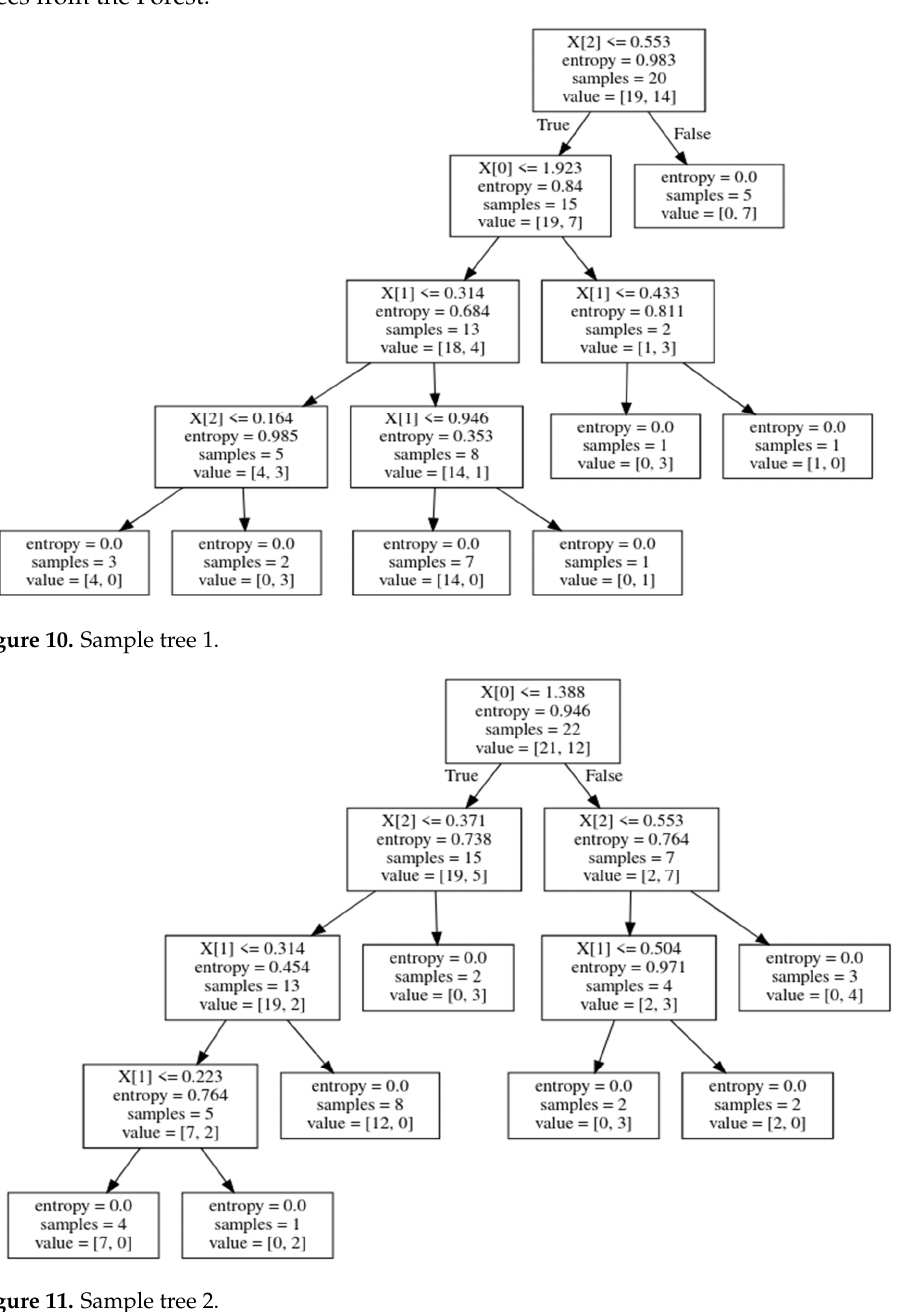
Figure 11. Sample tree 2 .